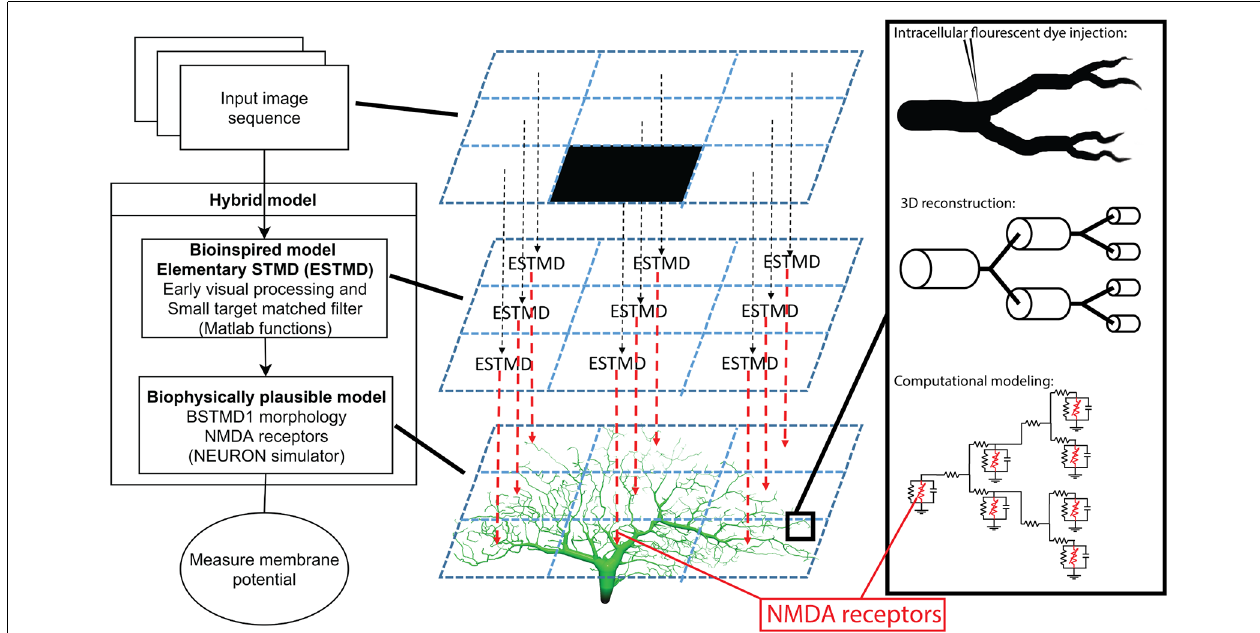
FIGURE 2 | Illustration of the hybrid model. To the left is an overview of the model and what type of processing and mechanisms each component consists of. The middle column is a simplified explanation of how an input image is mapped on to the dendritic tree. To the right is a magnified illustration of the dendritic tree and how it was simulated, from dye injected neuron, reconstructed cable (cylinders) model, to mathematical compartment (electrical circuit) model.